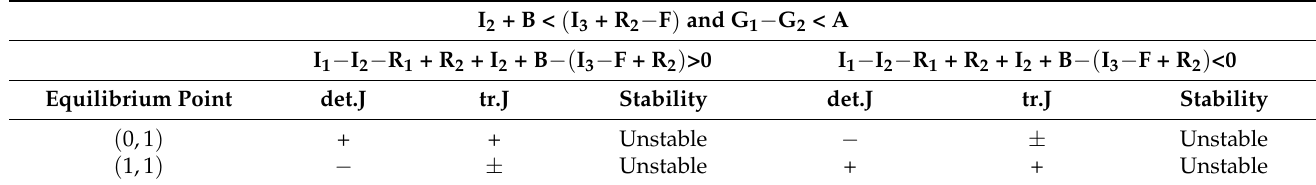
Table 9. Stability results of the local equilibrium point in Scenario 4.